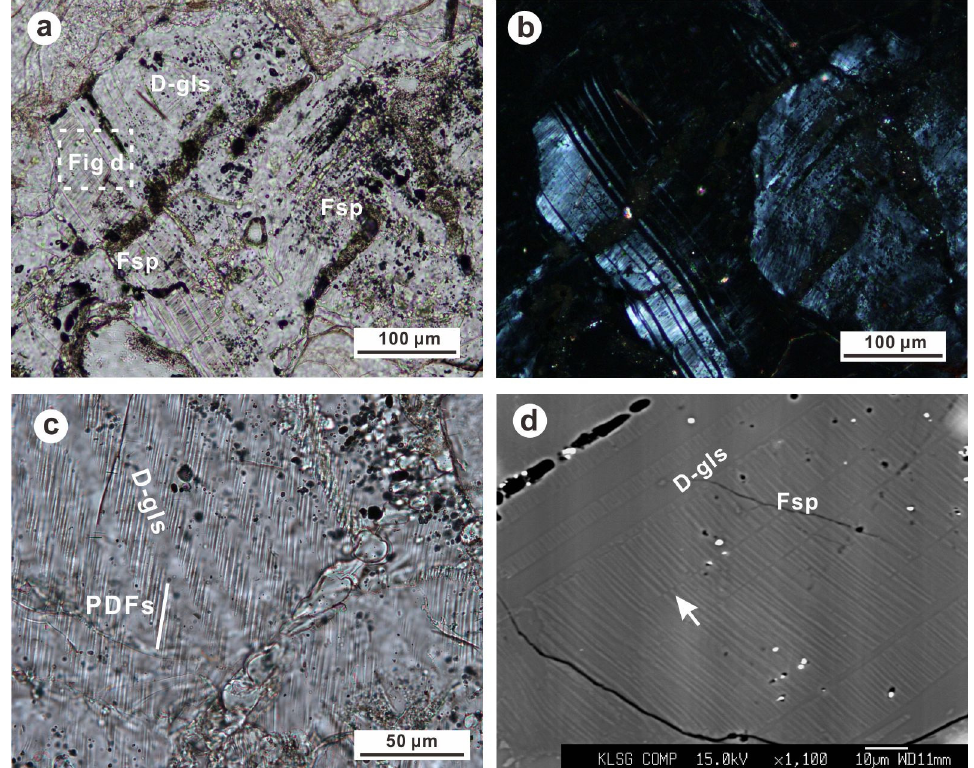
Figure 5. Moderately shocked feldspars. ( a , b ) Feldspar grains show an interference color of first order gray and are partially transformed into glass (a—PPL, b—XPL). ( c ) A feldspar grain shows one set of PDFs and diaplectic glass (PPL). ( d ) BSE image of the twin lamellae that have been converted to diaplectic glass. Fsp—Feldspar, D-gls—Diaplectic feldspar glass.